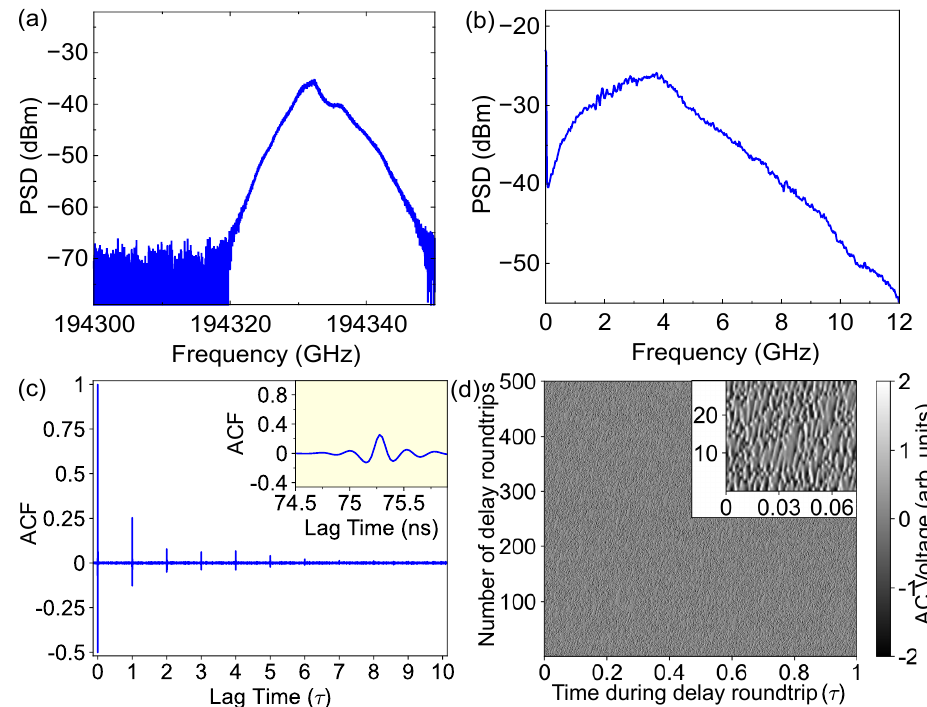
Figure 8. Exemplary dynamics at intermediate feedback levels. The bias current is I = 16 mA and the feedback rate has been attenuated by 13 dB from its maximum value. ( a ) Optical spectrum; ( b ) RF power spectrum; ( c ) Autocorrelation function (ACF) of the intensity time series with inset around the first delay echo, ( d ) Spatio-temporal representation of the intensity time series with inset for magnification around the